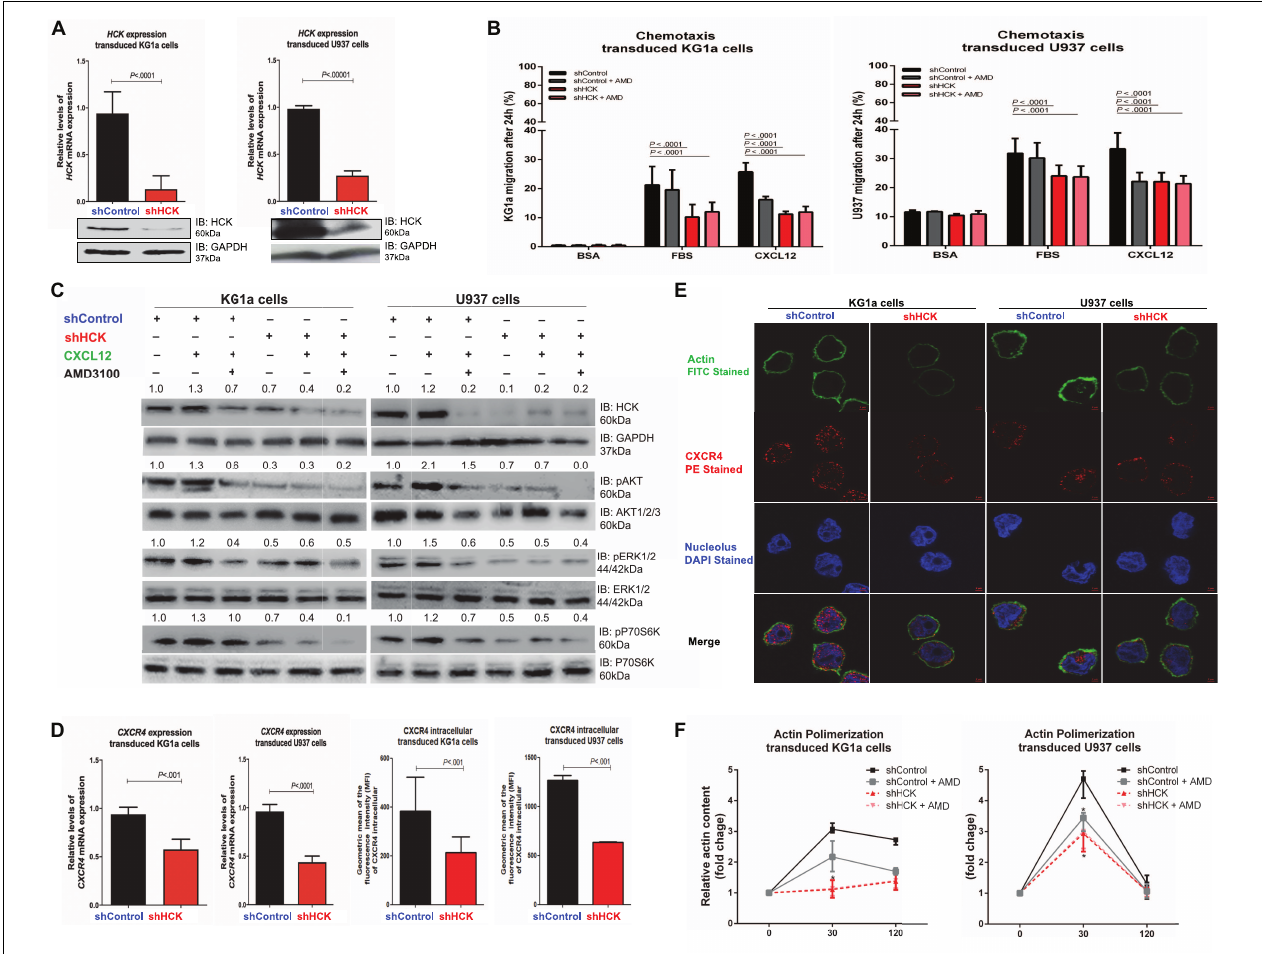
FIGURE 1 | HCK inhibition downregulates CXCR4/PI3K or MAPK pathways in leukemic cell lines, resulting in a reduction of cell chemotaxis through actin polymerization modulation. (A) HCK mRNA expression and HCK protein levels in transduced leukemia cell extracts. For qRT-PCR, results were calculated for each sample relative to the expression of the endogenous gene and determined using the 2 − (cid:49)(cid:49) CT method. All data have been normalized to the values of the control. For Western blotting, membranes were blotted with antibodies against HCK (60 kDa) or GAPDH (37 kDa), as a control for equal sample loading, and analyzed by chemiluminescence. (B) Chemotaxis assays in transduced leukemia cells. The Transwell system was used to detect the chemotaxis of shControl or shHCK cells toward CXCL12 (100 ng/mL), in the presence and absence of a CXCR4 antagonist (1.25 µ g/mL of AMD3100), using 10% FBS-containing medium as a positive control and 0.5% BSA-containing medium as the negative control. After 24 h, the migrated cells on the lower chamber membrane were counted. (C) Western blotting analysis of total cell extracts from transduced leukemia cell lines, stimulated or not with CXCL12 (100 ng/mL) and in the presence or absence of a CXCR4 antagonist (AMD3100). Membrane was blotted with antibodies against HCK (60 kDa), pAKT (60 kDa), AKT (60 kDa), pP70S6K (70 kDa), P70S6K (70 kDa), pERK1/2 (44/42 kDa), ERK1/2 (44/42 kDa) or GAPDH (37 kDa), as a control for equal sample loading, and developed with the ECL Western Blotting Analysis System. (D) CXCR4 mRNA expression and CXCR4 intracellular levels in transduced leukemia cells. For qRT-PCR, results were calculated for each sample relative to the expression of the endogenous reference HPRT gene and determined using the 2 − (cid:49)(cid:49) CT method. For flow cytometry, results were calculated using the MFI of CXCR4 intracellular expression after cell permeabilization. (E) Confocal microscopy changes in CXCR4 and F-actin cytoskeleton organization in transduced leukemia cell lines. shControl or shHCK cells were displayed with phalloidin (green), CXCR4 (red), and DAPI (blue) stains by 63 × oil immersion objectives. The black bars/lines represent results obtained from shControl cells, whereas the red bars/lines represent shHCK cells. (F) F-actin intracellular levels measured by flow cytometry in transduced leukemia cells. shControl or shHCK cells were stimulated with CXCL12 (300 ng/mL) for 30 or 120 s, in the presence and absence of a CXCR4 antagonist (AMD3100), stained with phalloidin, and then MFI was quantified by flow cytometry. Data indicate fold increase in F-actin content following stimulation with CXCL12. Results are shown as mean ± standard deviation and are representative of, at least, 4 independent experiments; Mann–Whitney test or Student’s one-tailed t -test.